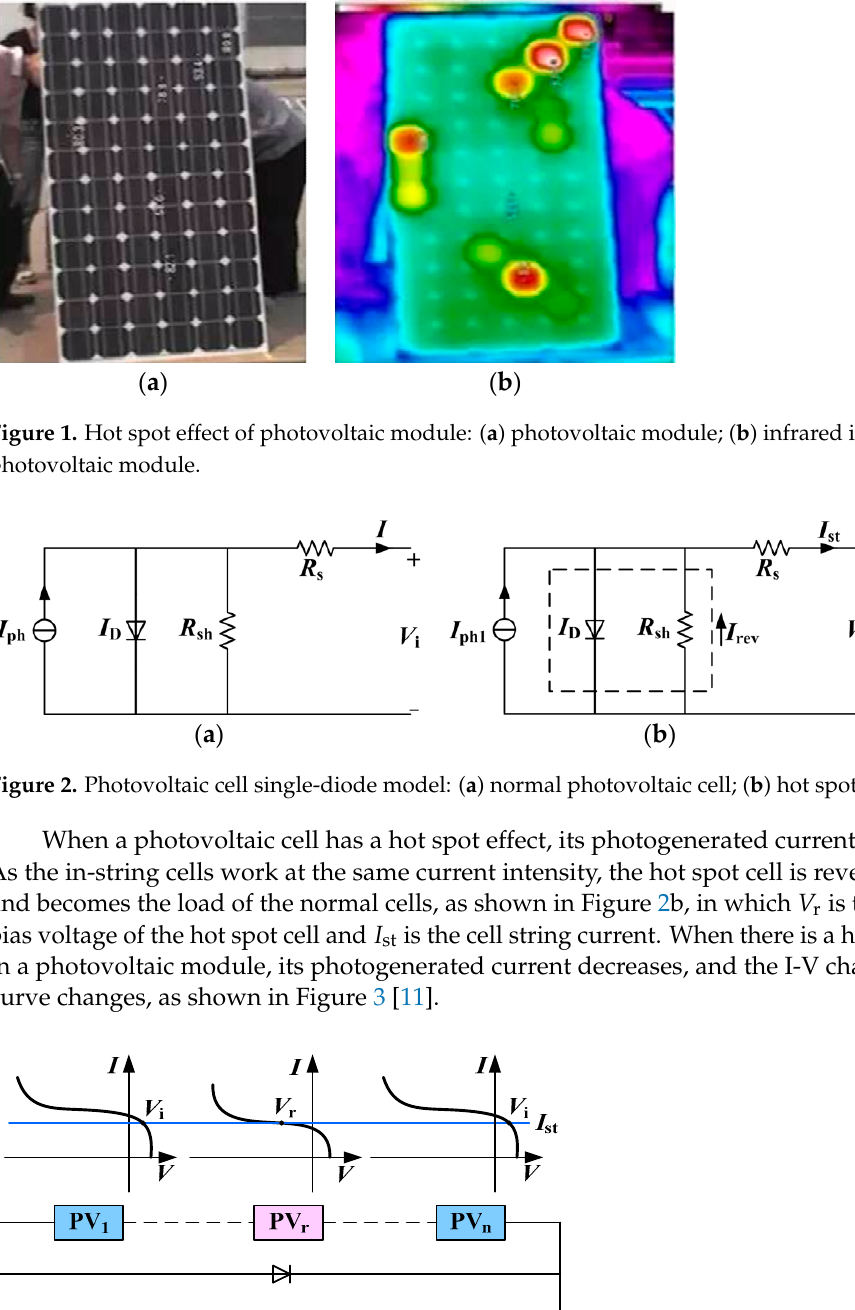
Figure 3. Schematic diagram of photovoltaic cell string and I-V characteristic curve.